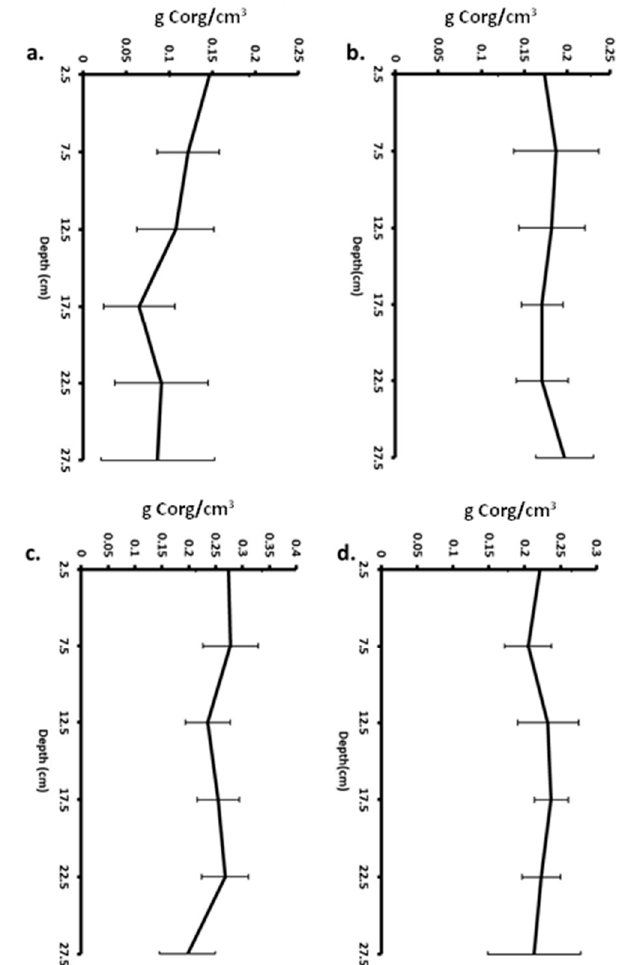
Figure 5. Depth profile in top 30 cm in meadows of ( a ). S. isoetifolium ( b ) C. serrulata ( c ) T. hemprichii and ( d ) T. ciliatum.